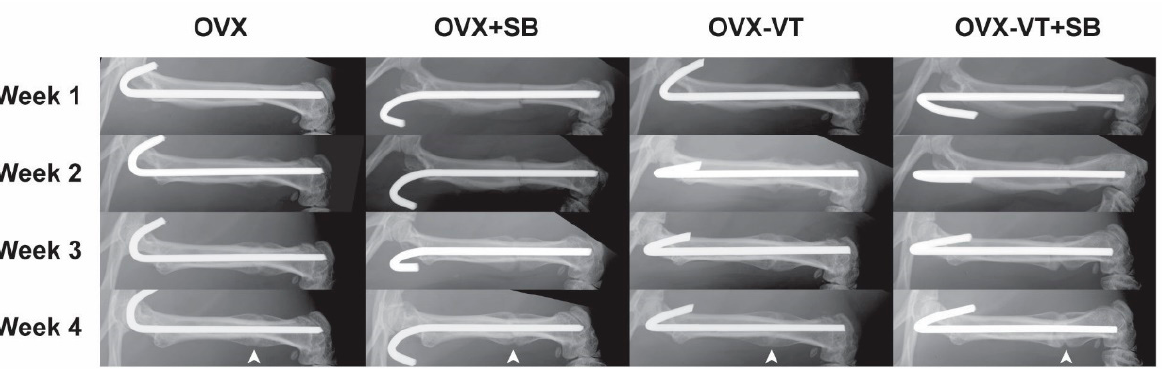
Figure 2. Representative x-ray images of the four groups from week 1 to week 4 during the early inflammatory stage to overlapping anabolic callus formation stage.